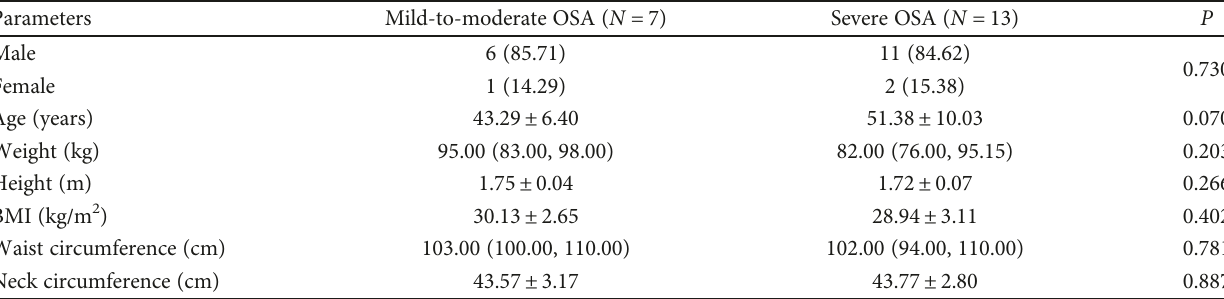
Table 2: Baseline characteristics of OSA with T2DM patients.